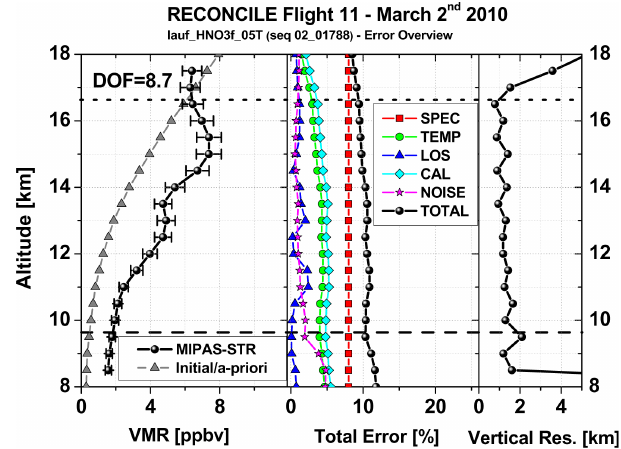
Fig. 13. Left side: retrieved vertical profile of HNO 3 with estimated error and initial guess/a priori profile (DOF=degrees of freedom). Middle: Different error contributions and estimated error in percent (SPEC=spectroscopic data, TEMP=temperature, LOS=line-of- sight, CAL=radiometric calibration, NOISE=spectral noise, TO- TAL=estimated 1 σ -error). Right side: Vertical resolution of the re- trieval result. The dotted horizontal line indicates the flight altitude of the Geophyisca and the dashed horizontal line the lowest tangent point of the